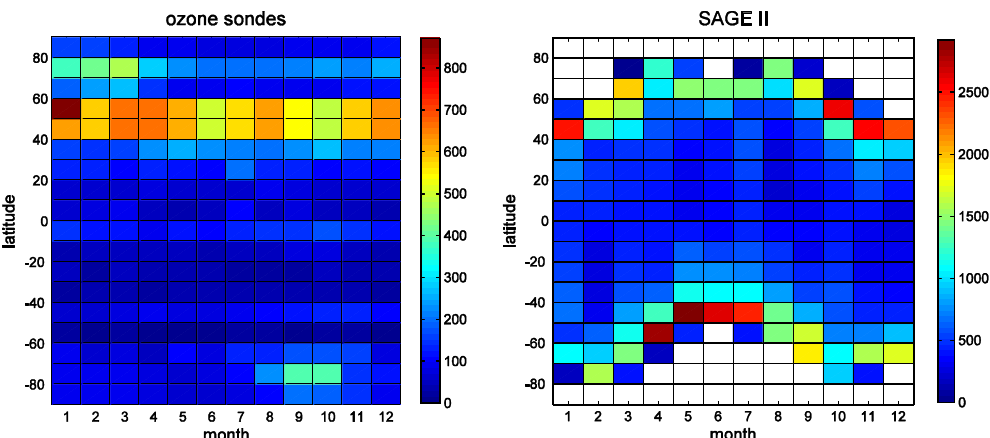
Fig. 1. Number of measurements in 10 ◦ latitude zones and in each month. Left: ozonesondes from the BDBP; right: SAGE